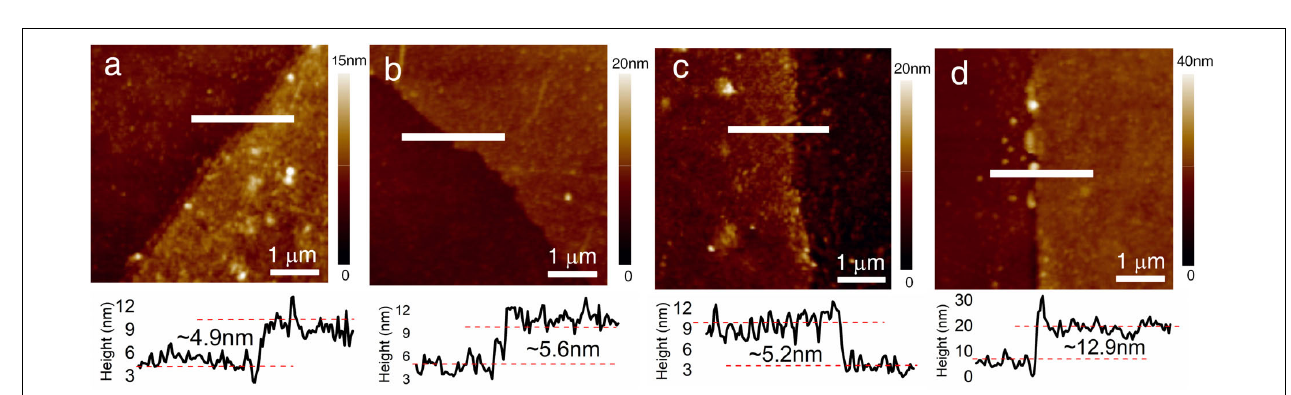
FIGURE 3 | The surface modification process and contact angle images of the devices. (A) The pristine graphene with a contact angle of 95.3 ◦ . (B) Surface modification with PBA. The PBA modified graphene with a contact angle of 83.2 ◦ . (C) EDC/NHS conjugation. (D) Self-assembled monolayer of BLUF-K 1 . The contact angle is 78.5 ◦ . (E) Self-assembled monolayer of BLUF- K 5 . The contact angle is 68.8 ◦ . (F) Cross-linking of BLUF-K 1 . The contact angle is 74.6 ◦ . (G) Cross-linking of BLUF-K 5 . The contact angle is 58.1 ◦ .